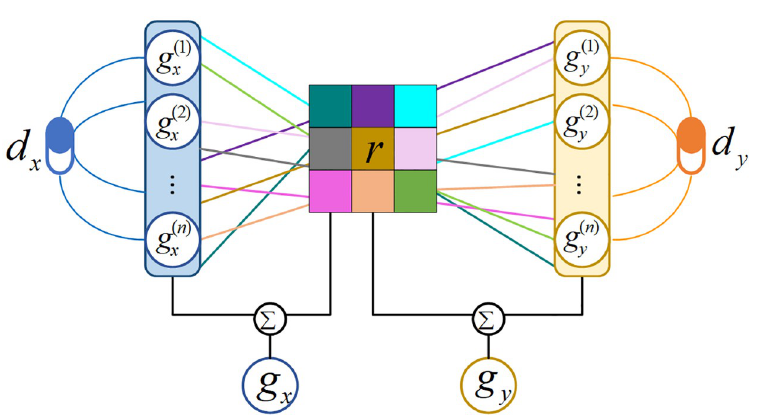
Fig 15. The overall computational steps for graph-level representation of d x and d y